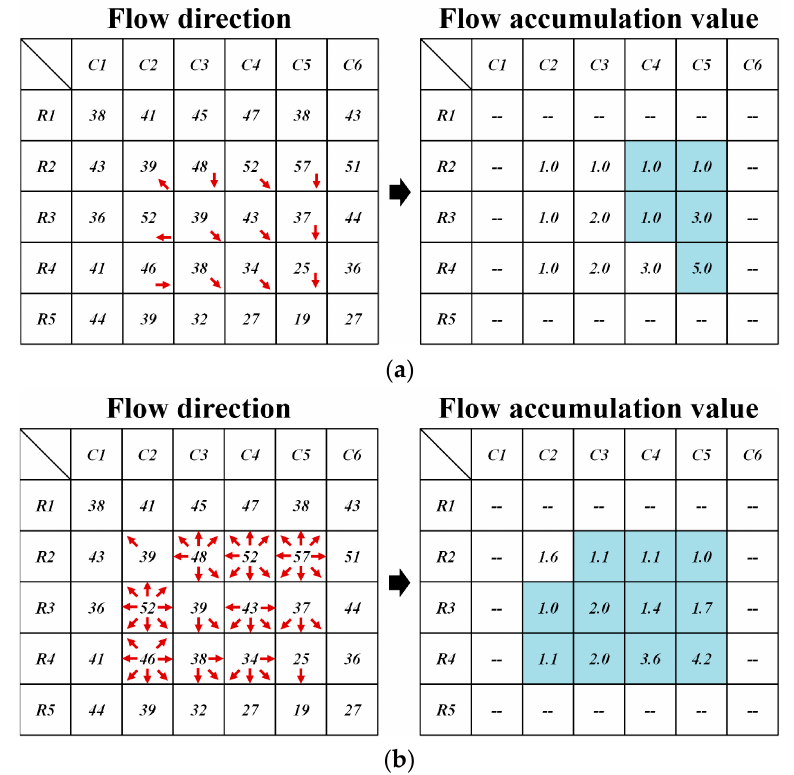
( c ) Figure 5. Variances between the flow dispersion area and the flow concentration area at the 300 locations using three selected flow-direction methods: ( a ) D8 method; ( b ) MD4 method; ( c ) MD8 method. According to the definition of flow dispersion area ( A D ), the watershed boundaries for the three designated locations (as shown in Figure 1) can be determined using different FD methods and shown in Figure 6a. For the watershed outlet at location A, the largest watershed extent ( A D ) among the three FD methods is equal to 25.57 km 2 when the MD8 method is applied. However, the MD8 method cannot guarantee collectnig the largest amount of flow volume due to its dispersion effect. For example, as shown in Figure 6a, the flow paths from a starting point in the upstream watershed are tracked individually using the D8, MD4 and MD8 methods. In fact, countless flow paths can occur when using MFD methods (MD4 or MD8) but only three of them are plotted to explain that there can be more than two outlet locations on the boundary grids to discharge the outflow. This causes the MFD method to be unable to collect a larger amount of water volume than the D8 method sometimes. In addition to checking the watershed boundary, the flow concentration area ( A C ) obtained from the flow accumulation value (FAV) was also investigated to evaluate the ability to collect flow volume for a designated point. The spatial distributions of flow concentration